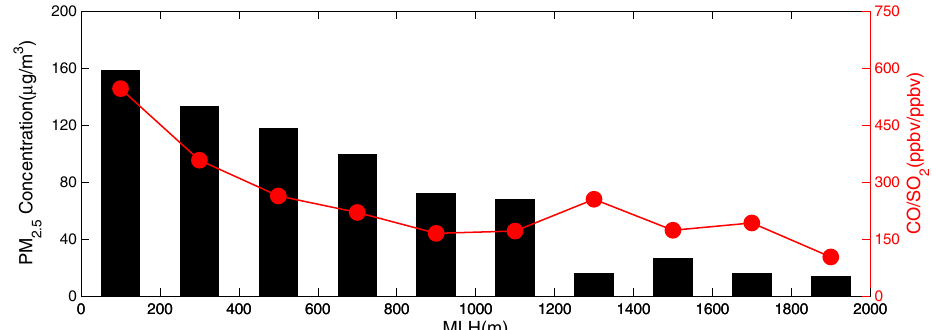
Figure 3. PM 2 . 5 concentrations and CO / SO 2 ratios of the mixing layer at different heights.